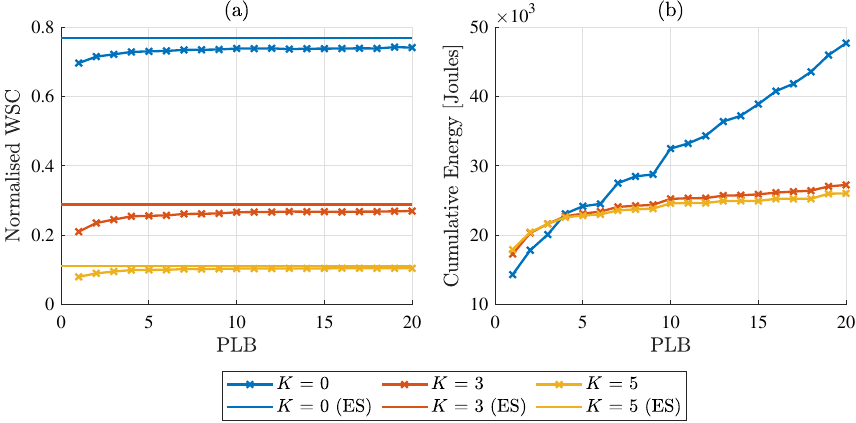
Fig. 7 a Normalised WSC mean values obtained over time, and b cumulative energy consumed in kilo‑Joules by all the UAVs over time. Both measured over PLBs with varying number of shape parameter K of the A2G links, compared to the exhaustive search (ES)